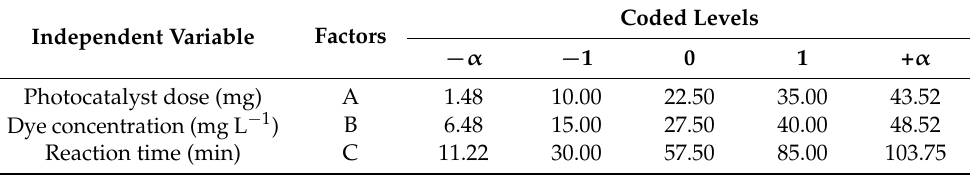
Table 8. Independent variables and their corresponding levels for the experimental design. Independent